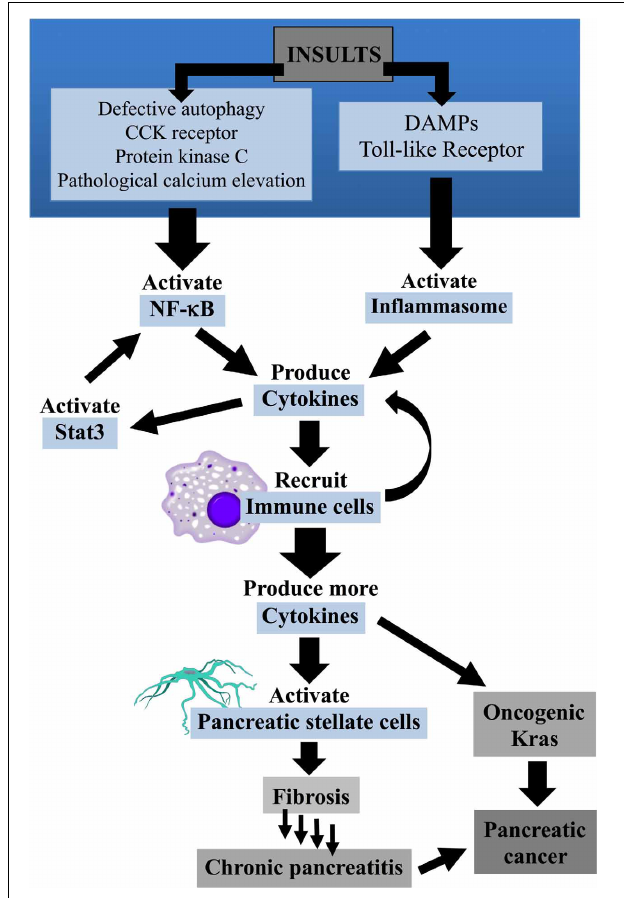
FIGURE 3 | Inflammation and pancreatic disease. Insults lead to the activation of NF- κ B and inflammasomes. NF- κ B activation leads to the production of cytokines which, in turn, recruit immune cells and activate Stat3. Neutrophils, macrophages and other immune cells infiltrate the pancreas and produce more cytokines amplifying the inflammatory response. Cytokines can lead to the activation of pancreatic stellate cells which can, with repeated bouts of acute pancreatitis lead to fibrosis and the development of chronic pancreatitis. Cytokines can activate oncogenic Kras, a characteristic of nearly 90% of all pancreatic adenocarcinomas. Chronic pancreatitis can also lead to the development of pancreatic